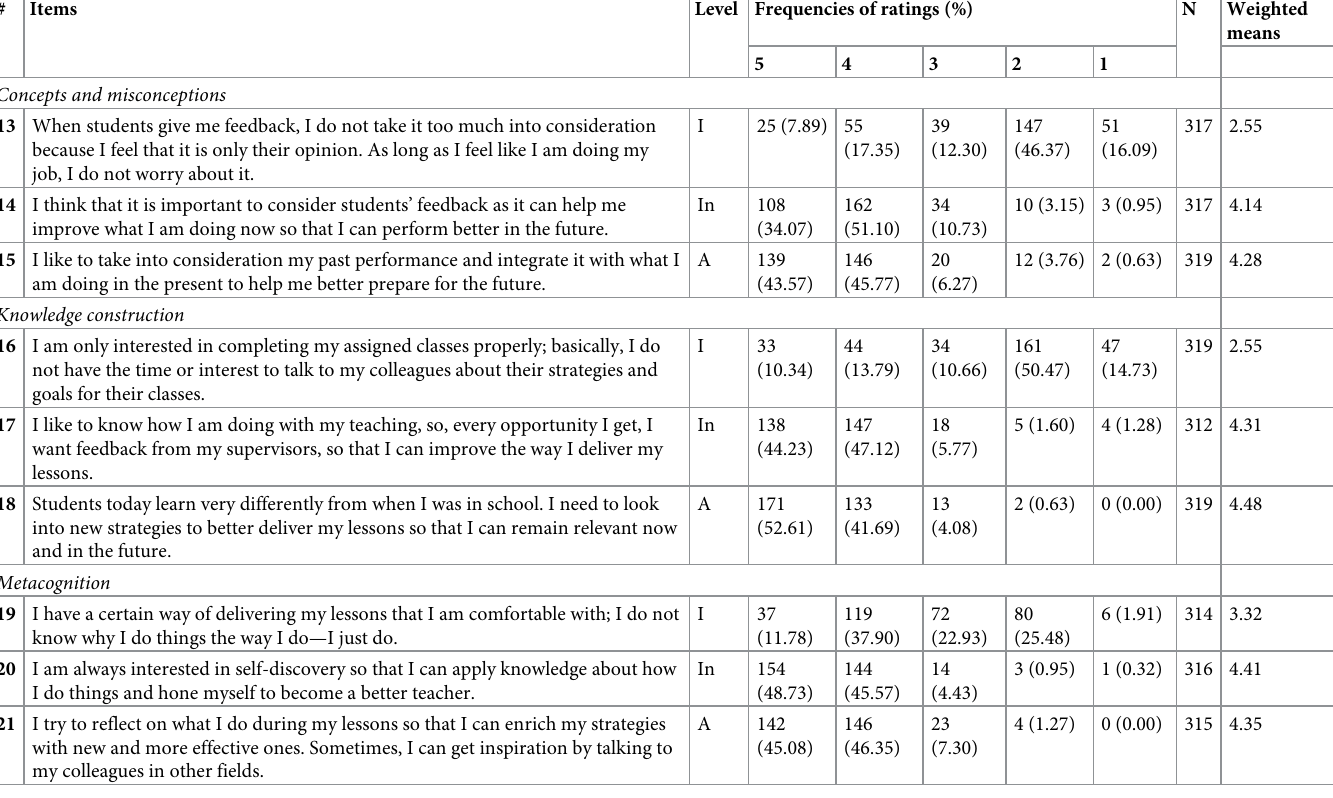
Table 2. Descriptive statistics for mathematics teachers’ awareness of how one